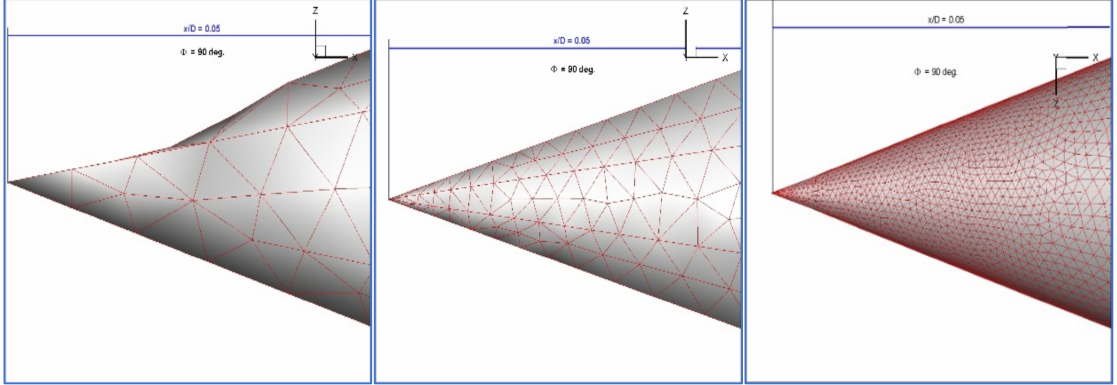
Figure 3. Detail of the surface mesh in the nose tip region for unstructured meshes of different grid